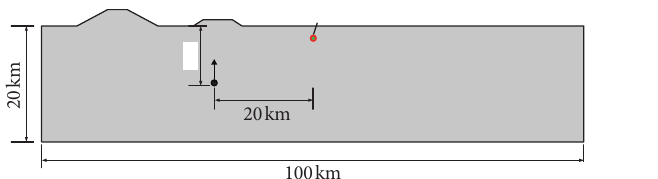
Figure 21: Large-range complex field with a length of 100km, and the underground